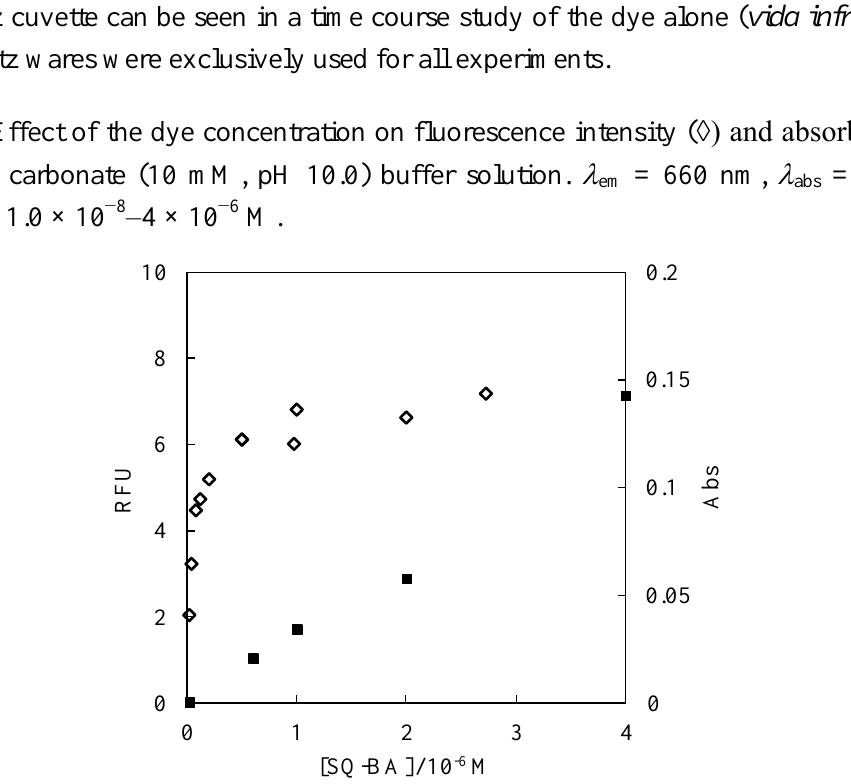
= 660 nm,  = 630 nm. em abs